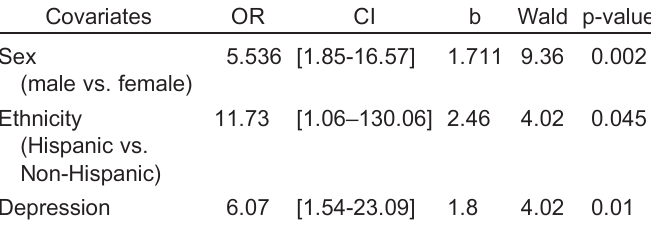
Table 4. Multiple logistic regression